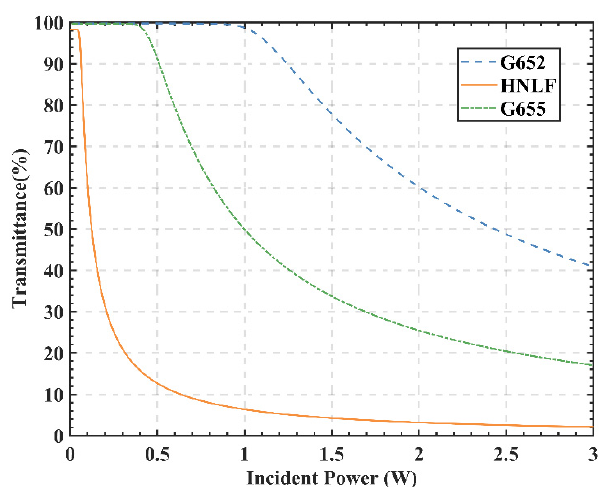
Figure 1. Numerical results of transmittances for HNLF and G655 and G652 fibers.